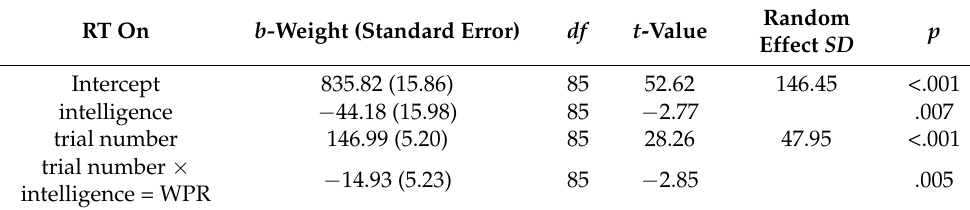
Random p Effect SD